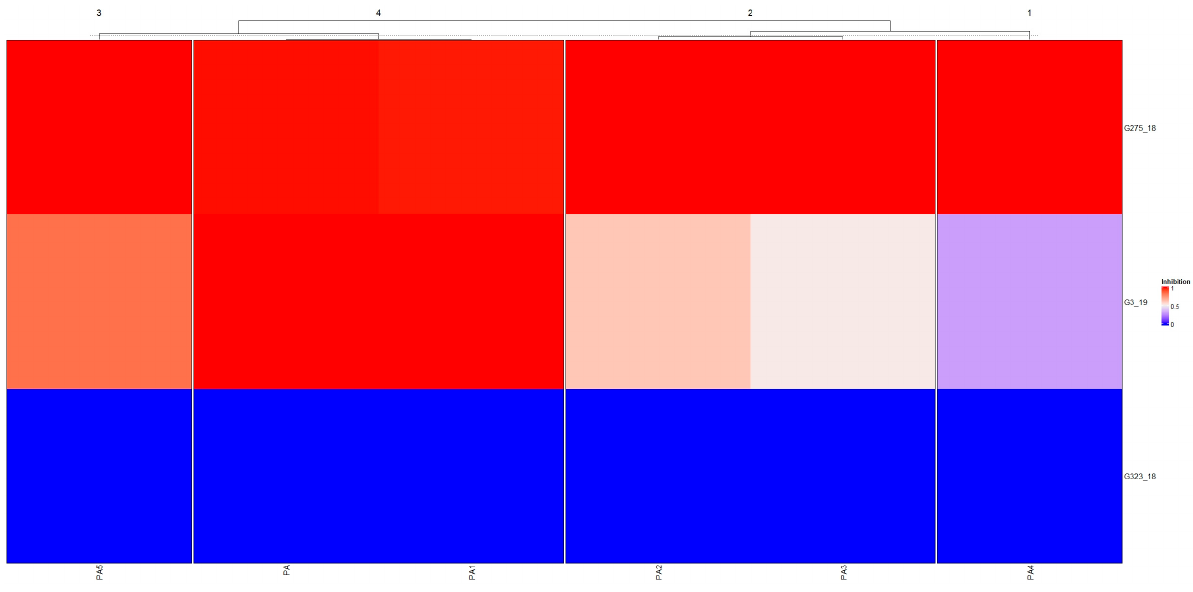
Figure 1. Inhibition profile of Botrytis cinerea . Colour scale of the heatmap indicates the inhibition degree (red represents stronger inhibition and blue represents lower inhibition). Abbreviations: PA is PA pure; PA1 is PA 1:2; PA2 is PA 1:8; PA3 is PA 1:16; PA4 is PA 1:32; and PA5 is PA 1:36.